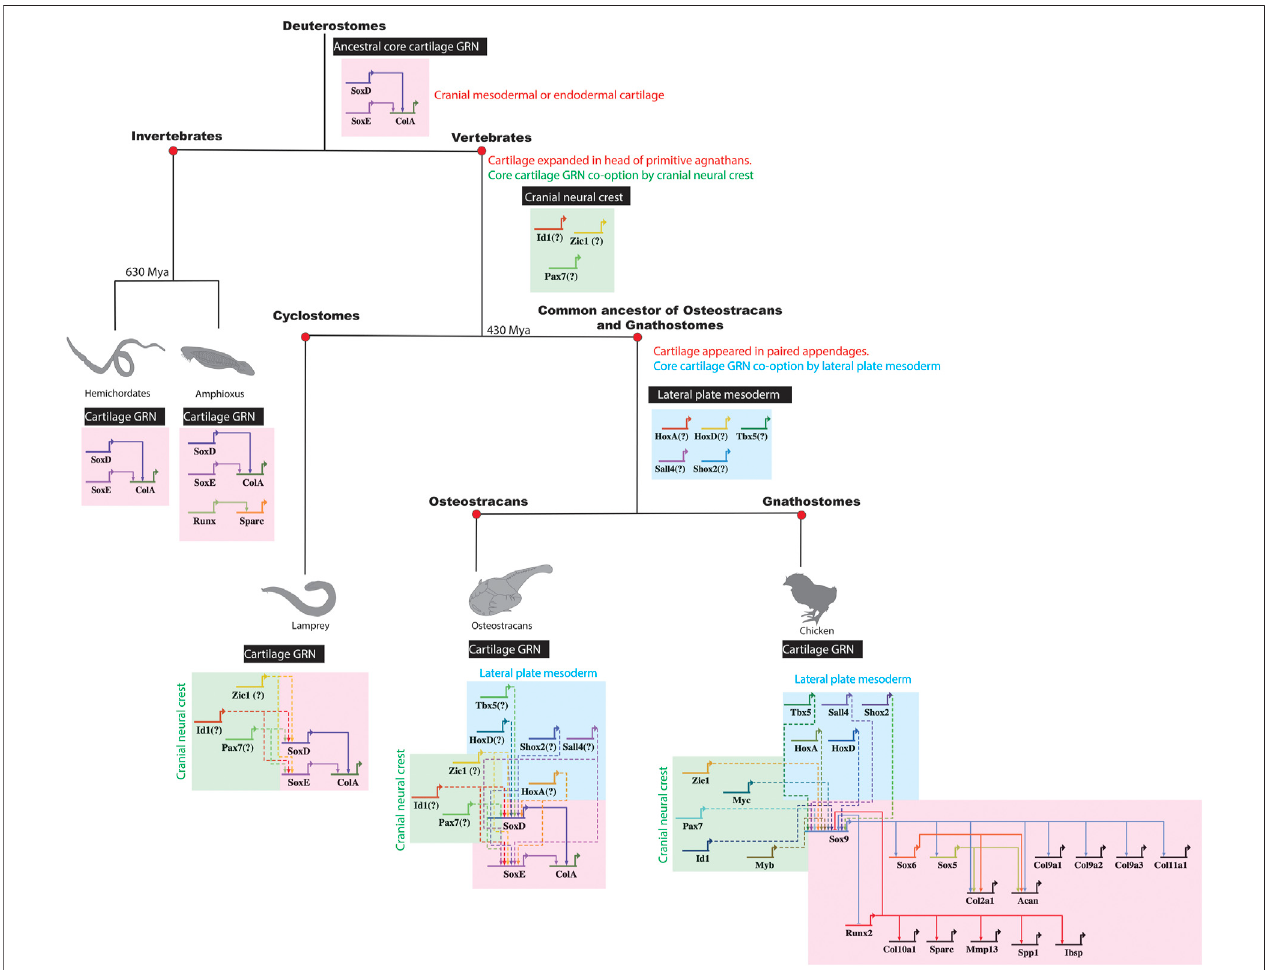
FIGURE 6 | Co-option of a core cartilage GRN by different embryonic populations during vertebrate evolution. The ancestral core cartilage GRN, shared in the common ancestor of vertebrates and their sister invertebrates, likely included such genes as SoxD , SoxE , and ColA expressed in cranial mesoderm or endoderm. In primitive agnathan vertebrates, cranial cartilage expanded when cranial neural crest cells co-opted a core cartilage GRN, likely building new regulatory connections between cranial neural crest genes and SoxE orthologs. Later, when paired appendages with cartilage evolved in the common ancestor of osteostracans and gnathostomes, a core cartilage GRN was additionally co-opted by lateral plate mesoderm, likely by establishing new regulatory connections between lateral plate mesoderm genes and SoxE orthologs.